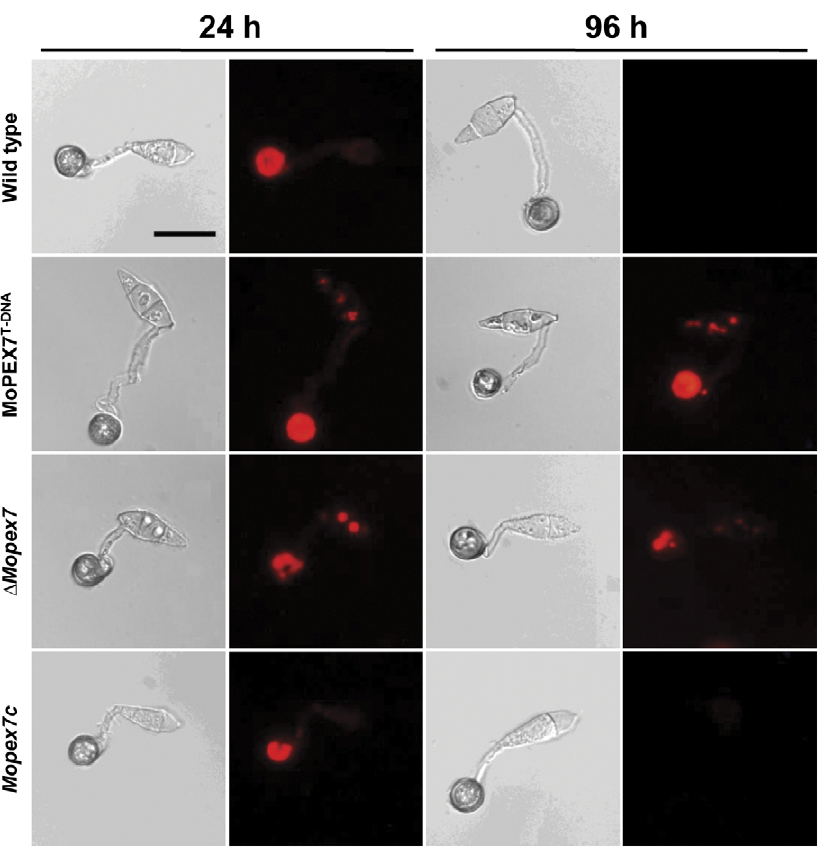
Figure 5. Appressorium morphology and localization of lipid droplets. Cellular localization of lipid droplets was observed after staining with Nile red. Bar=20 m m.